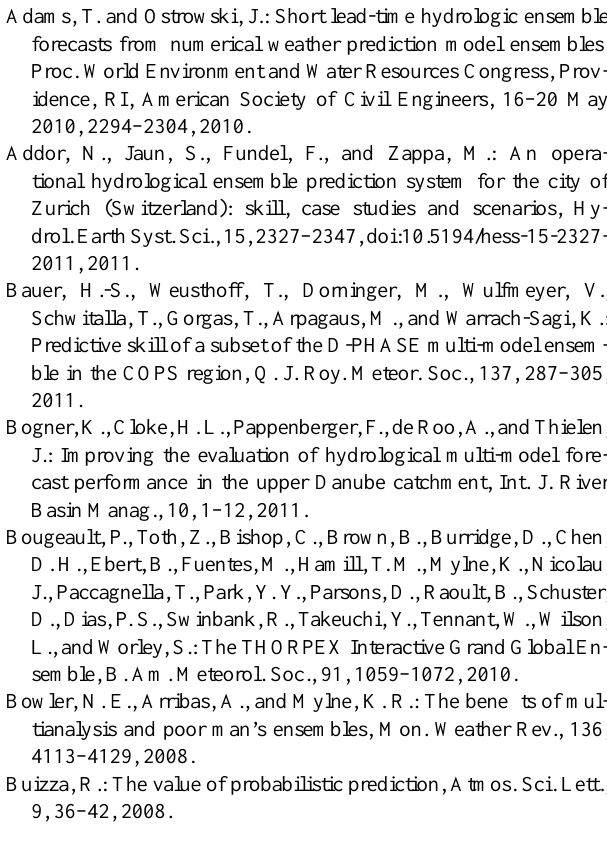
behaviour can be identified considering different